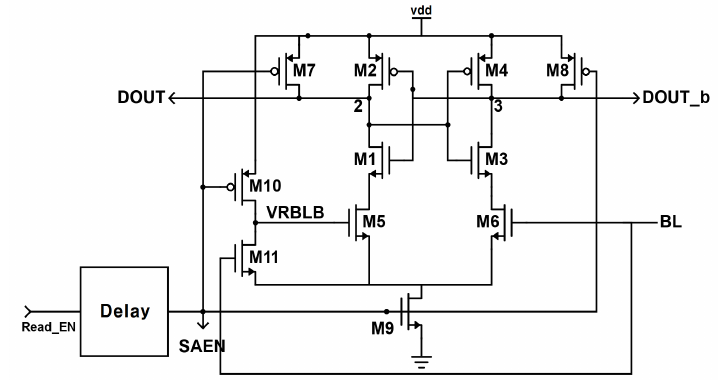
Figure 28. Schematic of sense